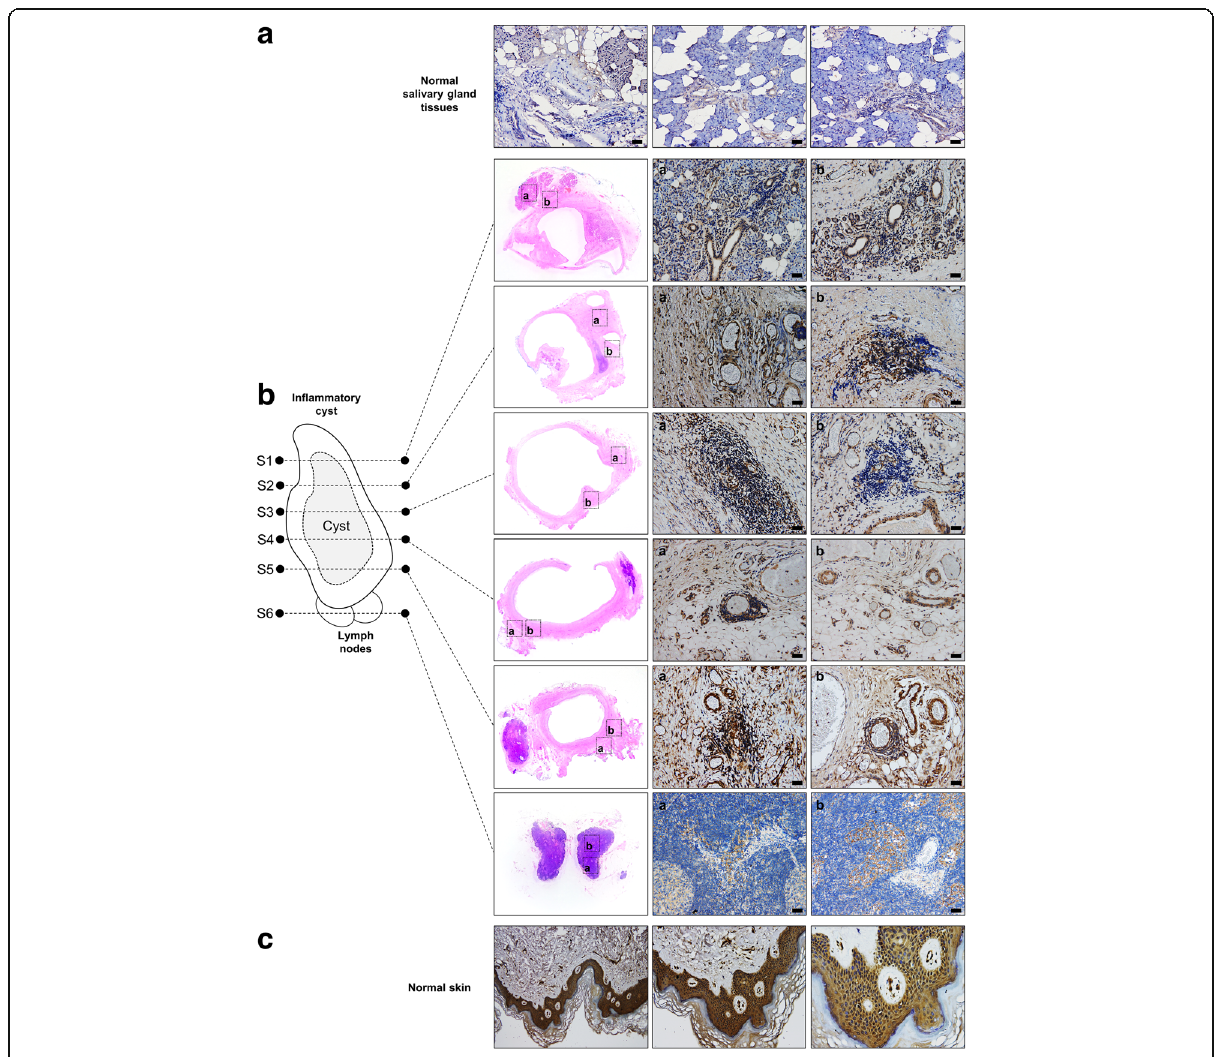
Fig. 2 Enhanced IL-34 expression in an inflammatory cyst of the submandibular gland compared to normal salivary gland tissues. Representative data of immunohistochemistry staining of IL-34 in normal salivary gland tissues ( a ) or inflamed submandibular gland ( b ). IL-34 staining was performed on sections obtained from five different regions of the surgically resected inflammatory cyst (from S1 to S5) in addition to one sample from the adjacent swollen lymph nodes (S6). H & E staining of sections is shown in the left column, followed by two representative data of IL-34 staining in tissues surrounding the inflammatory cyst. Squares within H & E photography indicate the correspondent positions of IHC data. Scale bars, 20 μ M. The specific staining of IL-34 in keratinocytes of normal skin is shown in c at different magnifications as a positive control to confirm the specificity of the anti-IL-34